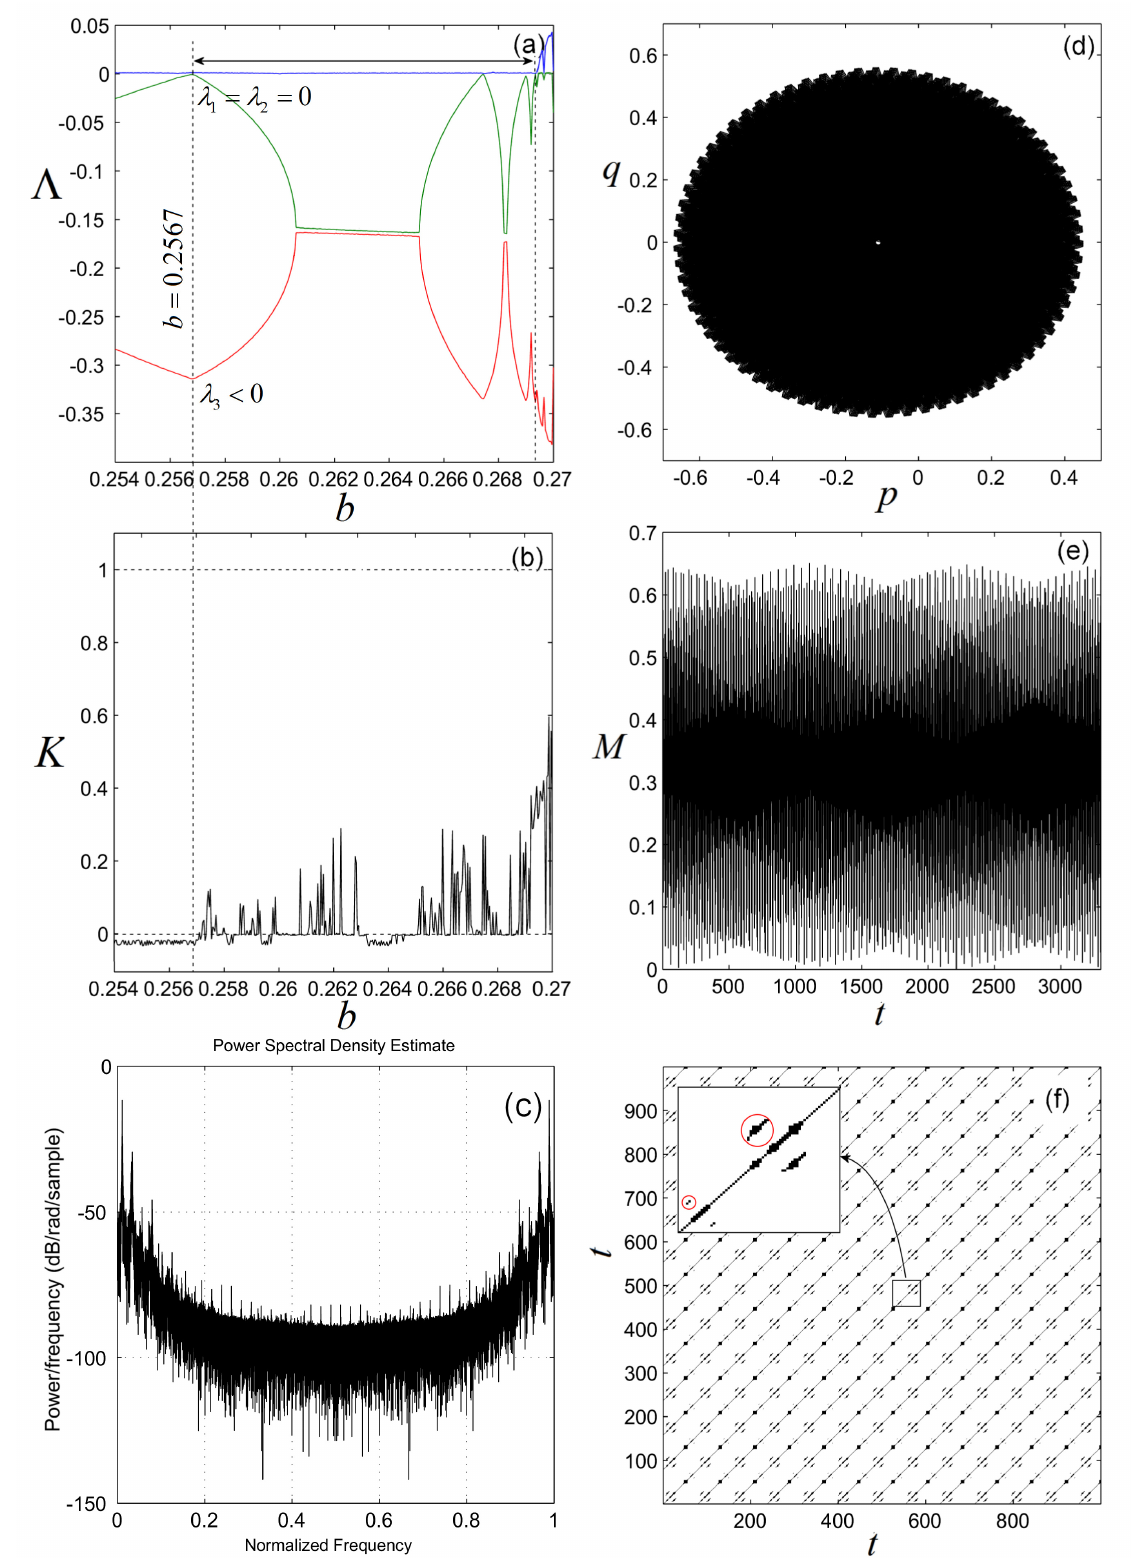
Figure 4. The quasiperiodic attractor for b = 0.25675. ( a ) The variation in the Lyapunov spectrum; ( b ) the variation in the median K ; ( c ) power spectral density; ( d ) the graph of p and q ; ( e ) the graph of the mean-square displacement M ; ( f ) the recurrence plot and zoomed